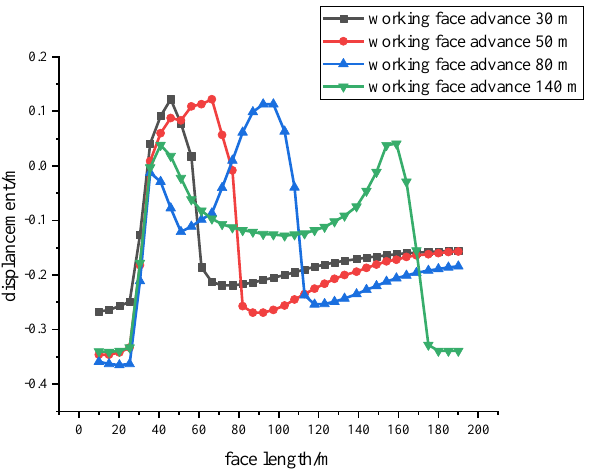
Figure 7. Displacement diagram of roof of the working face advancing at different distances.